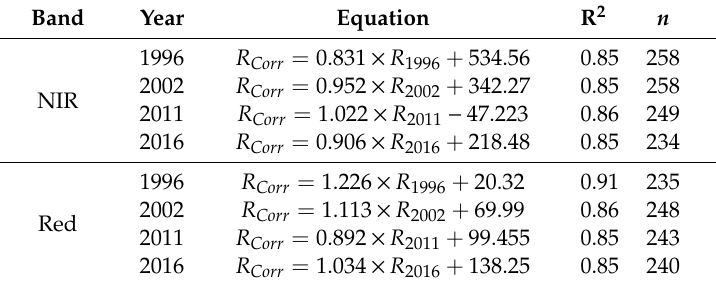
Table A1. Empirical line corrections for radiometric rectification.